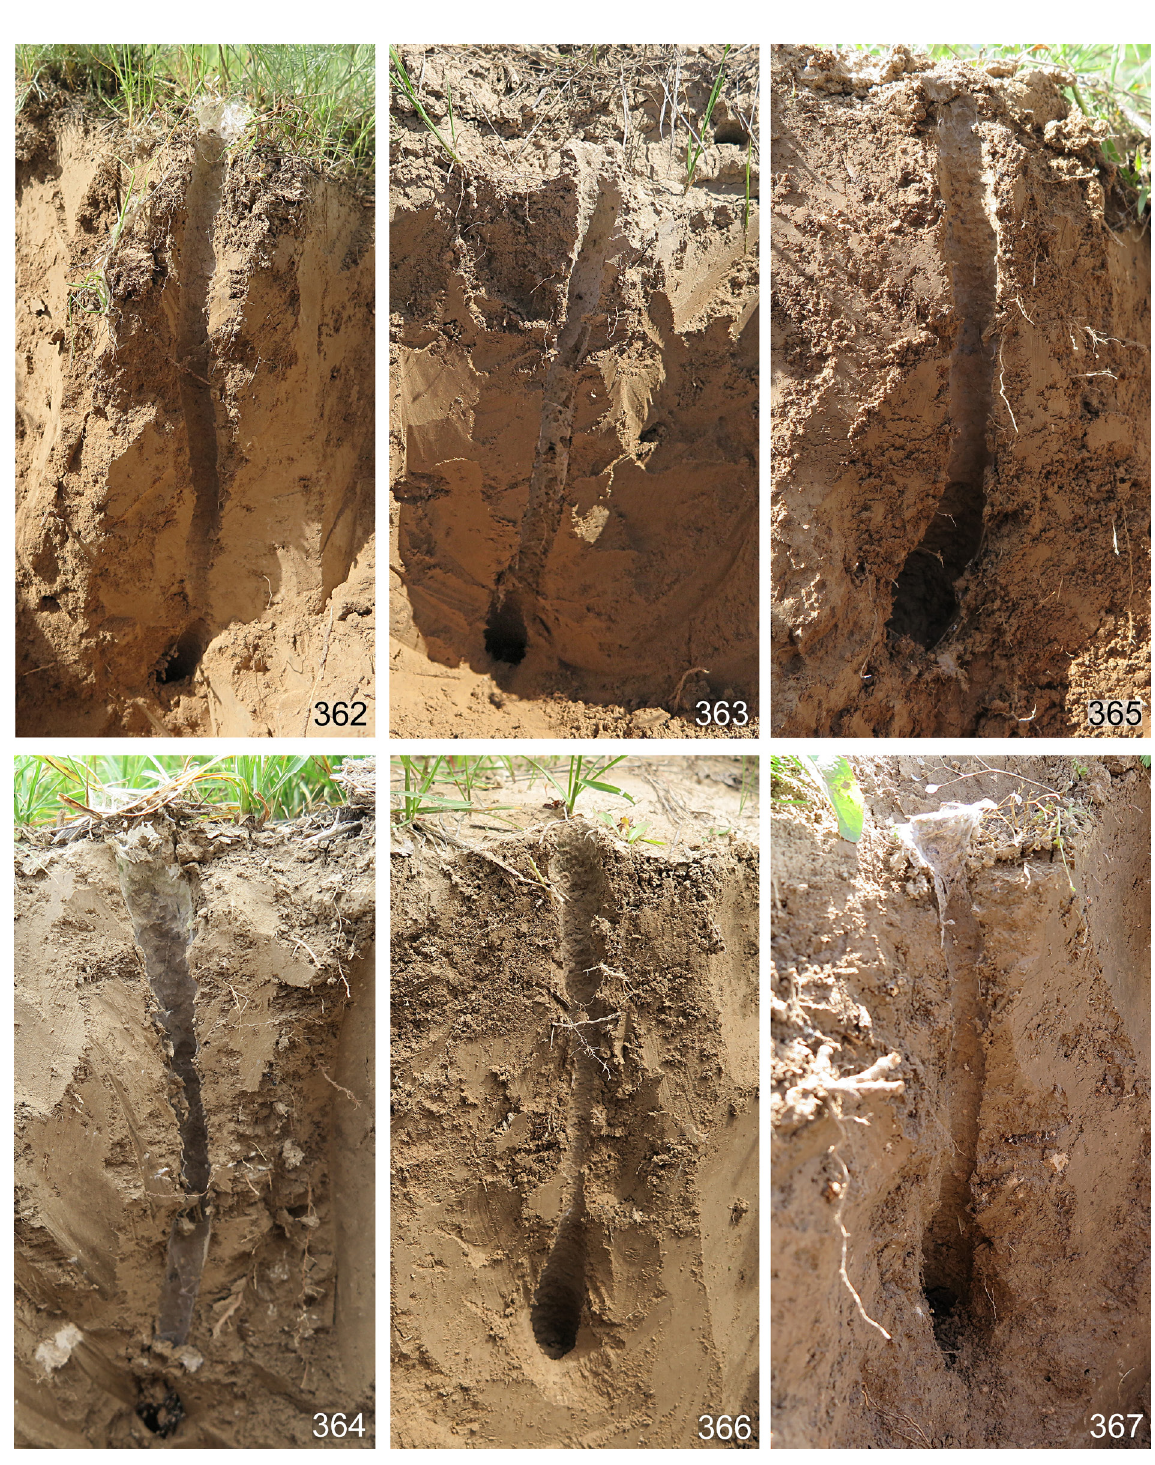
Figs 362–367. Anemesia spp., burrows in cross section, dug and exposed laterally;